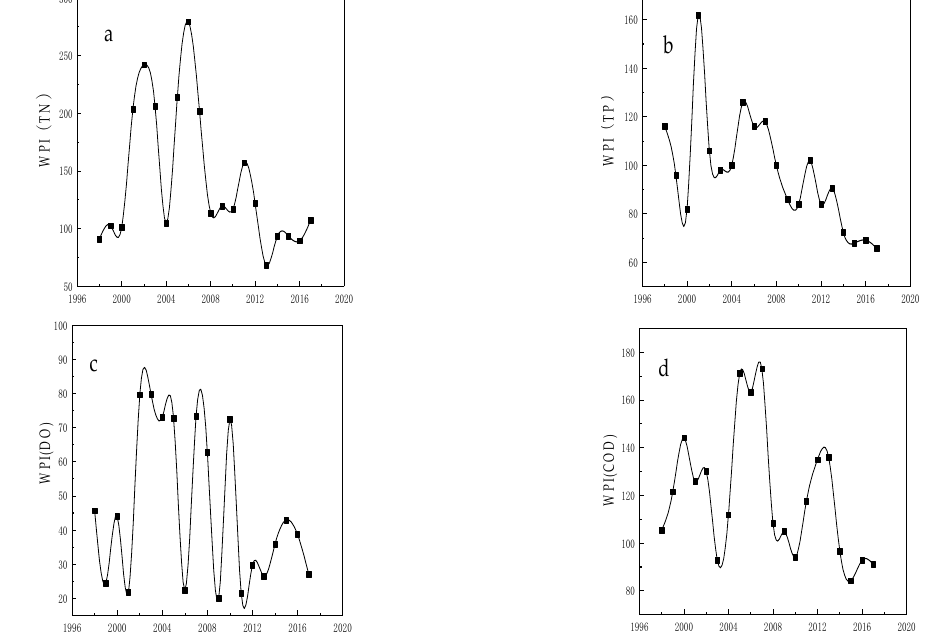
Figure 2. Inter-annual variation in the trends of the WPI TN , WPI TP , WPI DO , and WPI COD : ( a ) WPI TN ; ( b ) WPI TP ; ( c ) WPI DO ; ( d ) WPI COD .